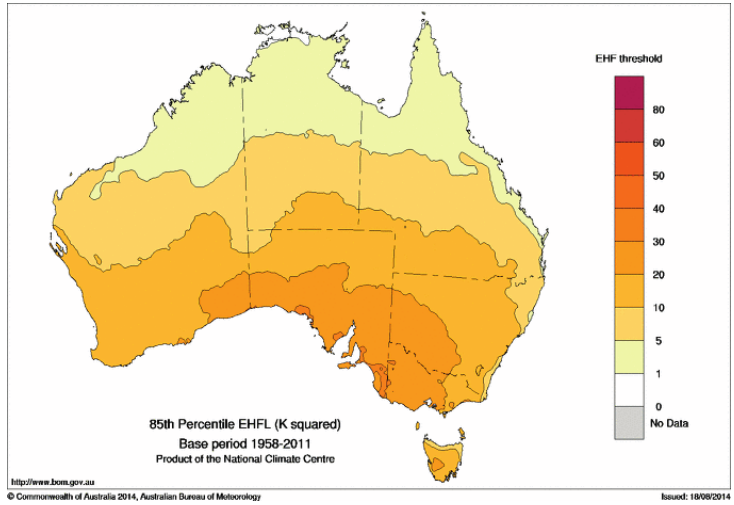
Figure 8. 85th percentile of positive EHF values in the period 1958–2011 (in K 2 ). These values are used as the threshold for a heatwave to be designated severe. The threshold for an extreme heatwave is taken to be three times the threshold for a severe